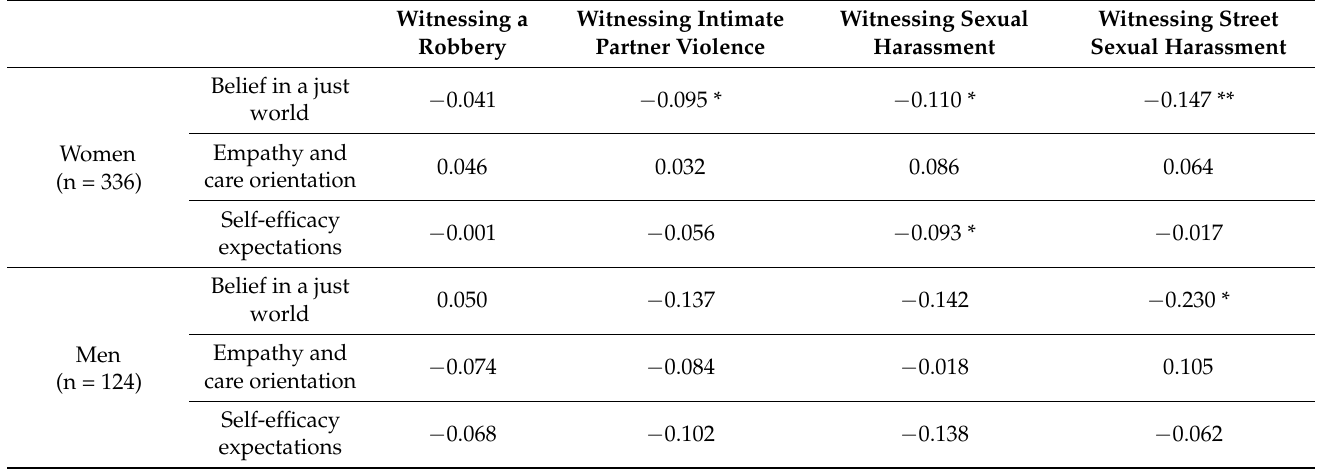
Table 6. Relationship between characteristics of people who help and experiences as violence witness.